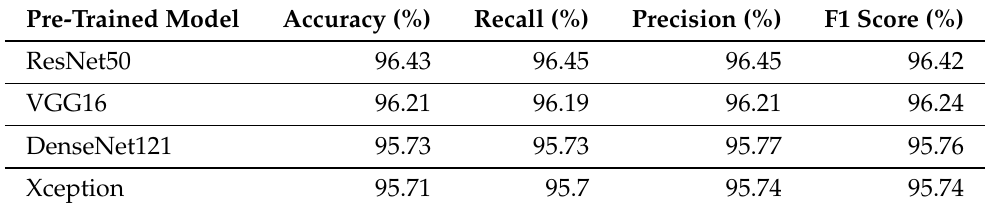
Table 3. Experimental results for the selection of the backbone